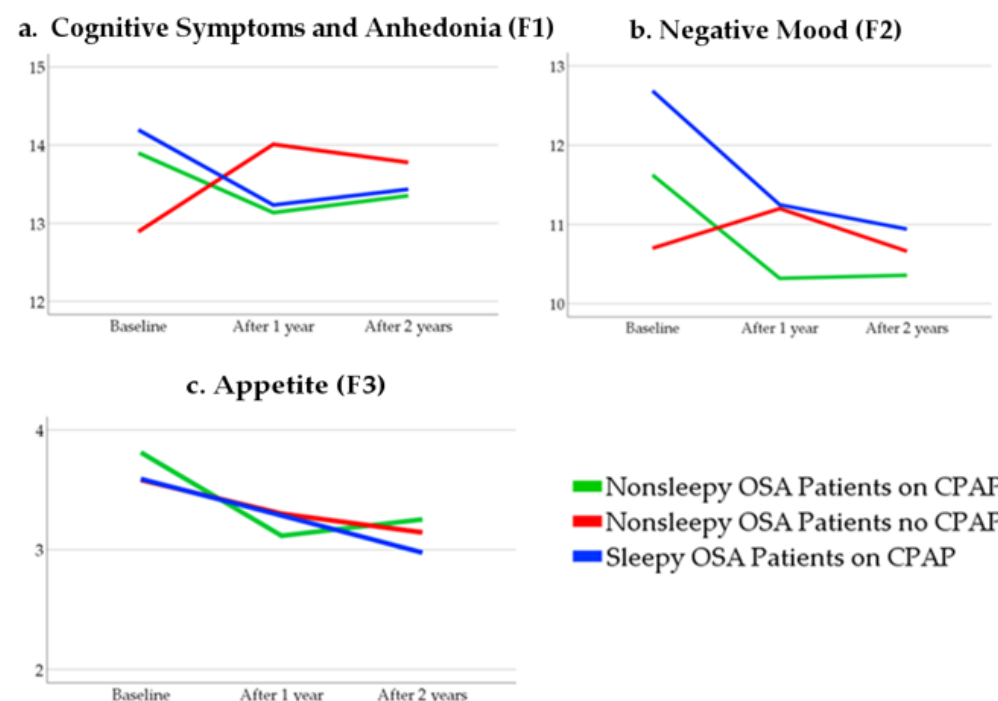
Figure 4. Linear trends (estimated mean values) of the Zung Self-rated Depression subscales over time in the study groups. ( a ). Cognitive Symptoms and Anhedonia (F1); ( b ). Negative Mood (F2); ( c ). Appetite (F3). CPAP, continuous positive airway pressure; OSA, obstructive sleep apnea.